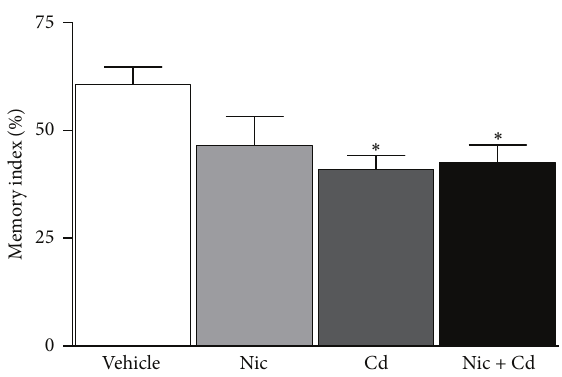
Figure 4: Novel object recognition memory index. A significant decline in memory index was observed in the cadmium and combined (nicotine-cadmium) treatment groups ( 𝑃 < 0.05 ) when compared with the control. Although nicotine treatment recorded no statistically significant decline in memory index, empirical quantification shows a decline in the memory index versus the control. However, comparing the nicotine treated group with the combined treatment group demonstrates the effect of cadmium in facilitating decline in memory function when coadministered with nicotine, similar to what is observed in tobacco smoke ( statistical significance : ∗ 𝑃 < 0.05